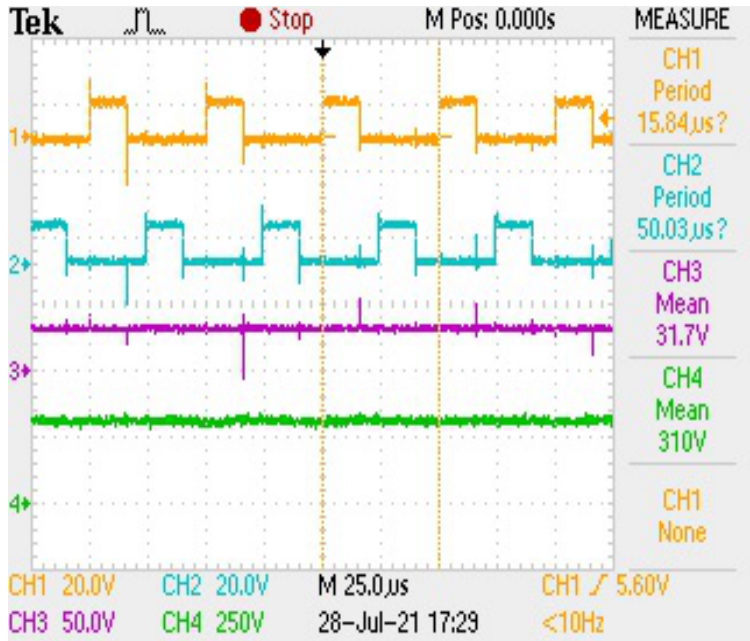
Figure 9. Gate pulses: input voltage and output